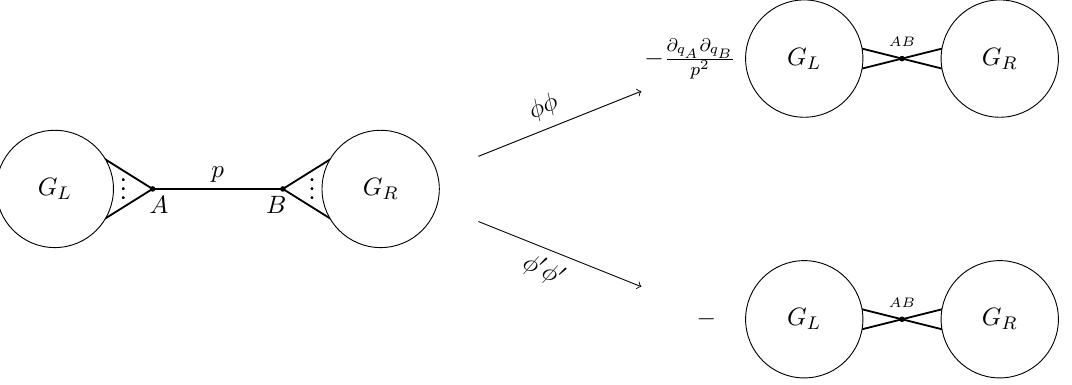
Figure 6 . Here we depict edge collapsing in the case of φφ and φ 0 φ 0 propagators. For φφ we need a factor of p − 2 ∂ whereas for φ 0 φ 0 just a factor of − 1 q A ∂ q B